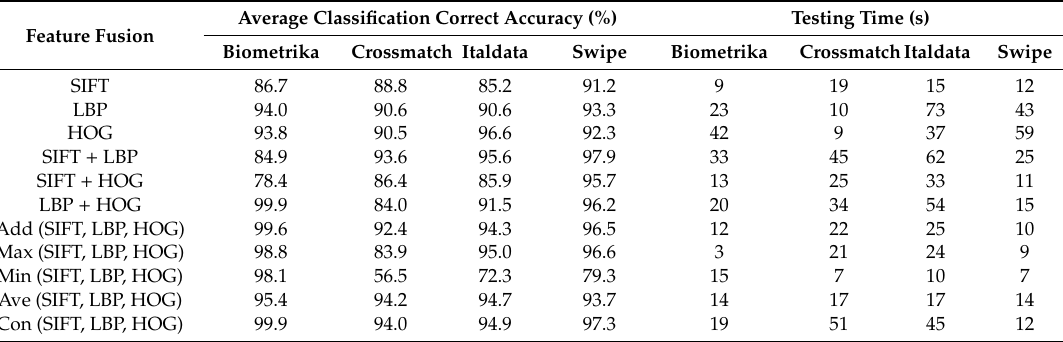
fingerprint set.